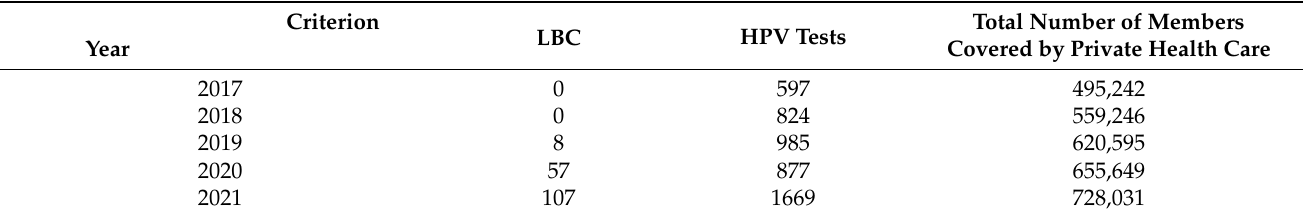
Table 5. Number of tests performed (LBC and HPV tests) and number of members—private health care.